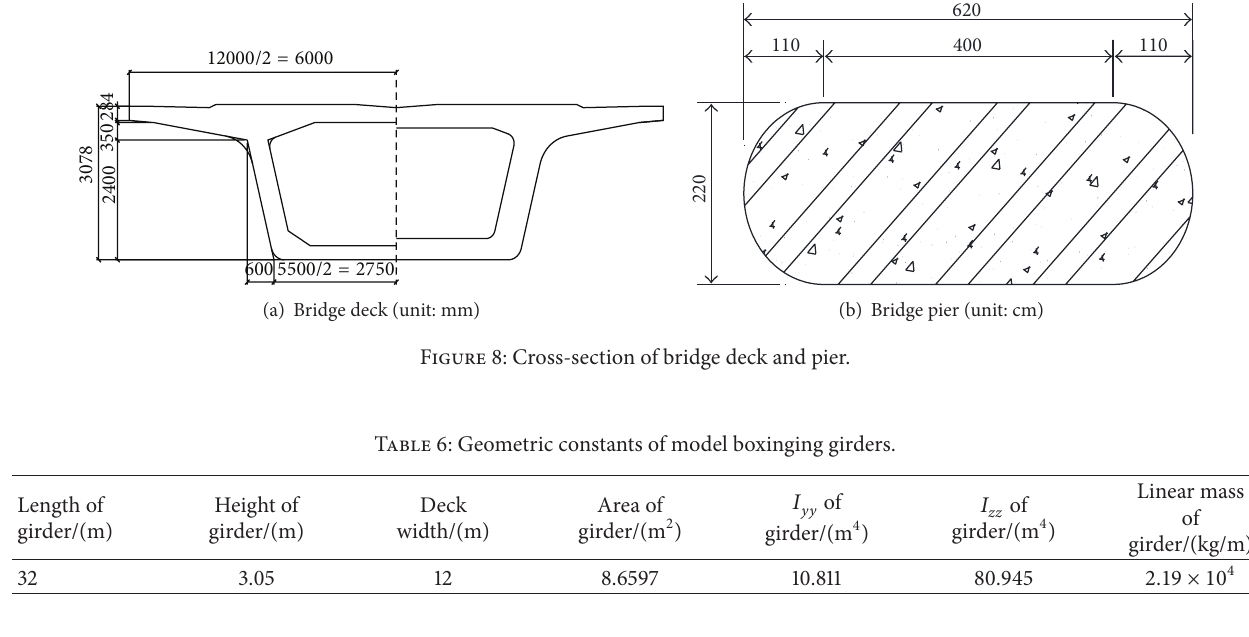
Table 7: Geometric constants of model round-shaped solid